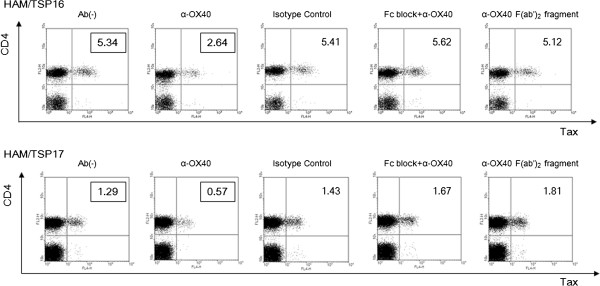
Anti-OX40 monoclonal antibody specifically eliminated naturally infected CD4+ T cells via antibody-dependent cell-mediated cytotoxicity (ADCC) in cultured PBMCs. Anti-OX40 mAb (clone B-7B5) reduces the percentage of Tax-positive cells, whereas the isotype control mAb (clone 2C2: anti-HIV-1 gp21, mouse IgG1) has no effect on Tax expression (1st, 2nd, and 3rd panels from left). Culture of PBMCs with anti-CD16/CD32 (Fc receptor) antibody to block Fc receptors abolishes Tax suppression by anti-OX40 mAb (4th panels from left). F(ab’)2 fragment do not suppress Tax exppression (right panels).